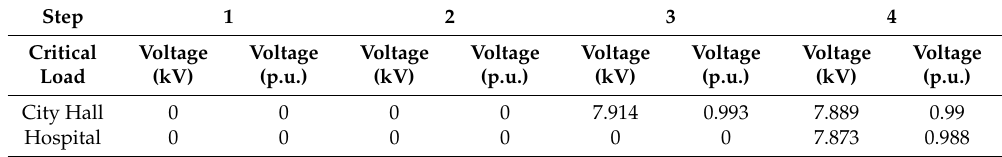
Table 5. Voltages at the Critical Loads